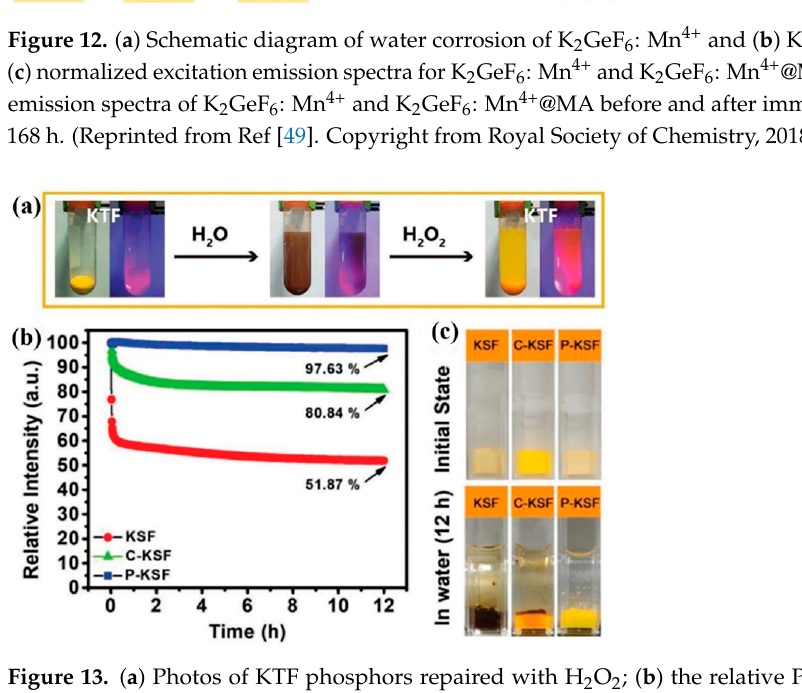
3 h, the PL intensity of shell Rb 2 SnF 6 : Mn 4+ was 95% of that at room temperature (RT) after